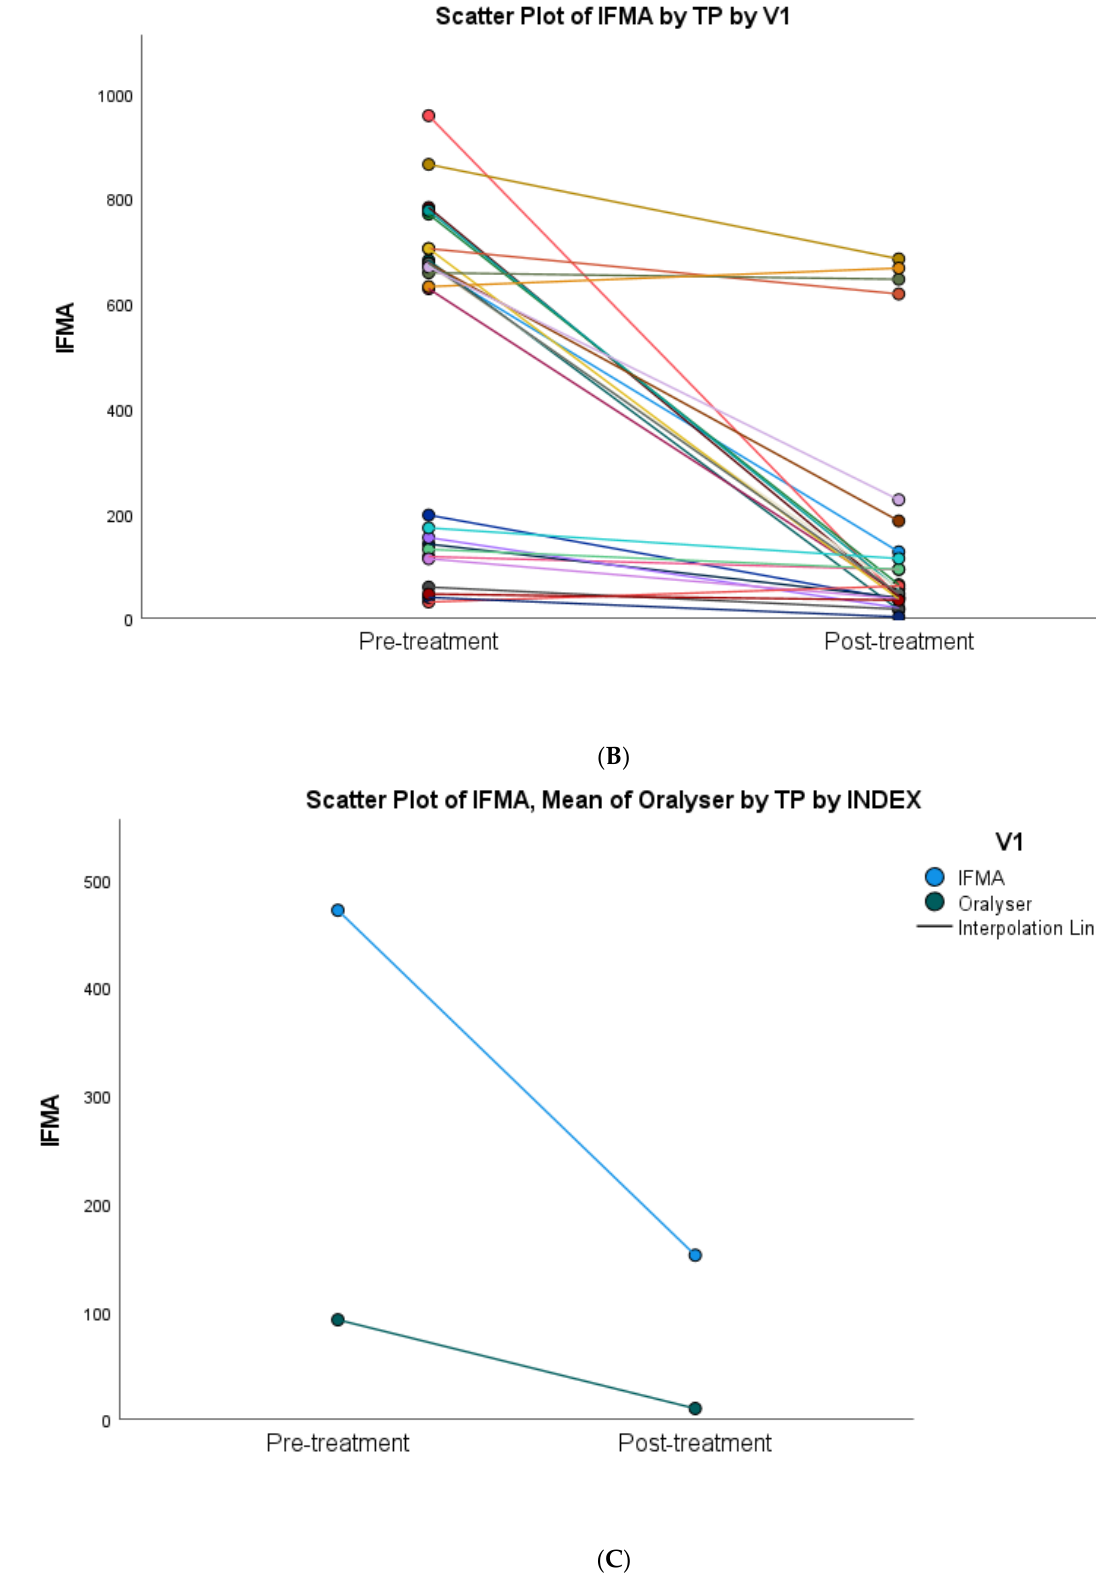
Figure 5. Scatter plot diagrams showing the effect of anti-infective periodontal treatment on aMMP-8 levels : ( A ) Oralyzer ® ’ ( B ) IFMA ; ( C ) regression lines of means.